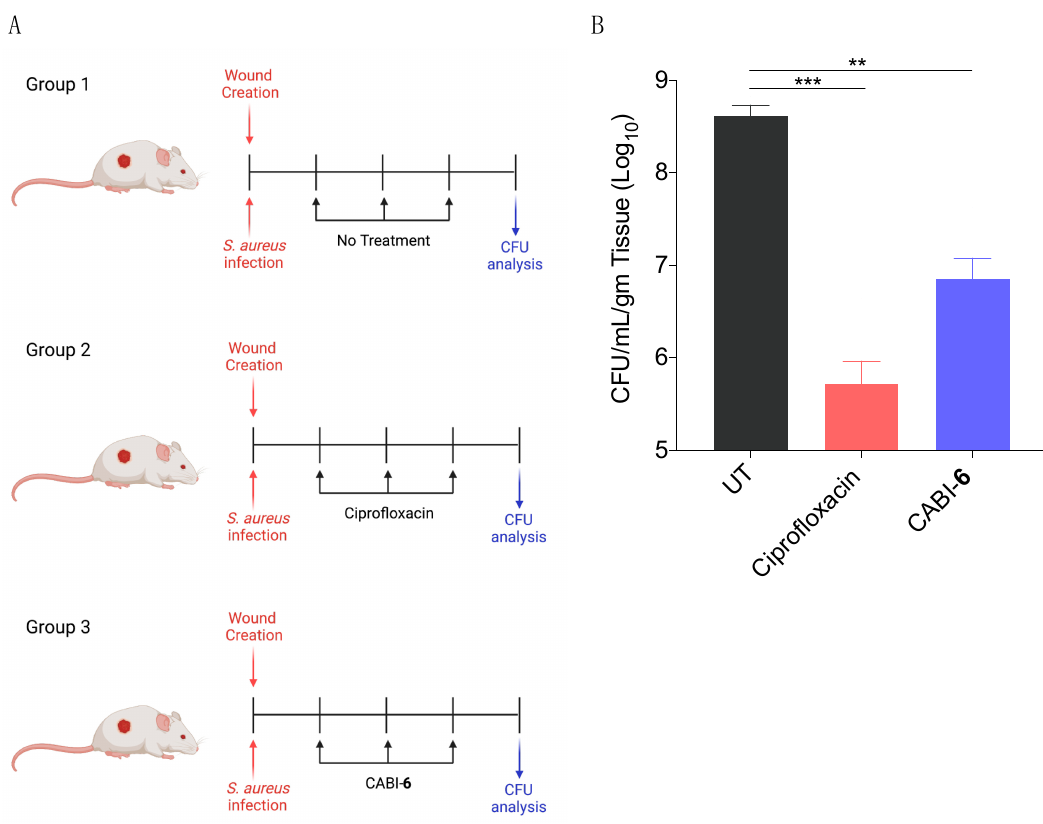
Figure 5. ( A ) Schema representing the experimental plan and different treatment groups (5 mice per group). ( B ) CFU analysis of S. aureus infected wounds post 3 days of treatment display that CABI- 6 can reduce the bacterial burden by >1.5-log as compared to untreated wounds. Data was analysed by ANOVA (**** p <0.0001; ** p <0.001).